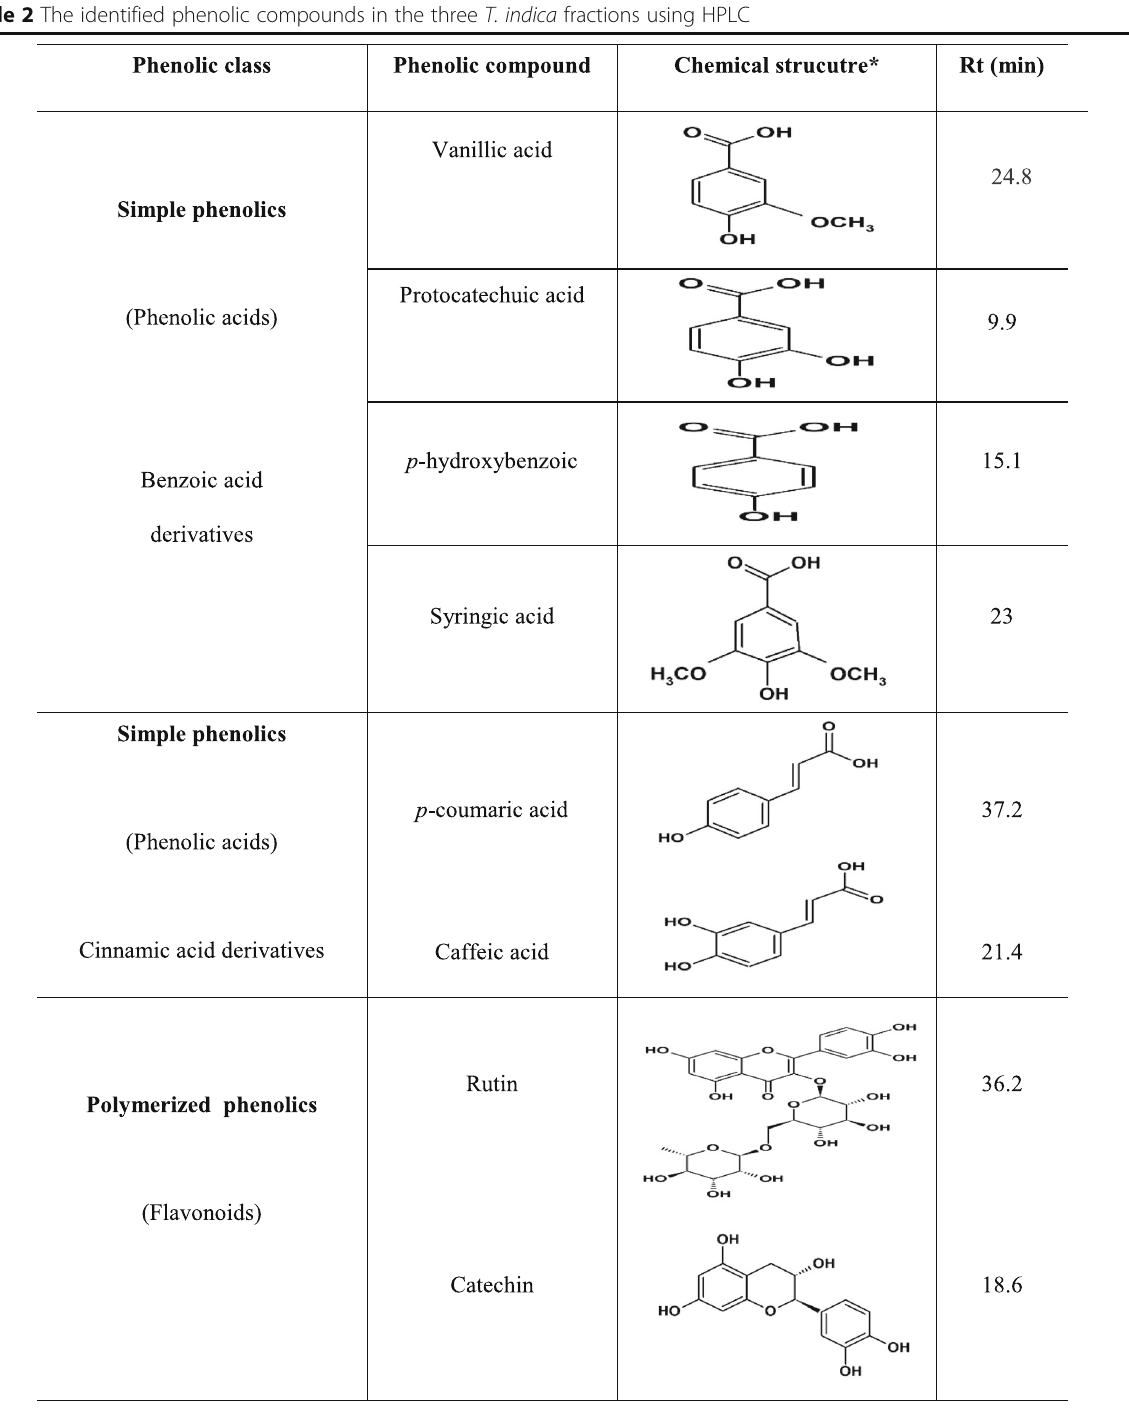
Table 2 The identified phenolic compounds in the three T. indica fractions using